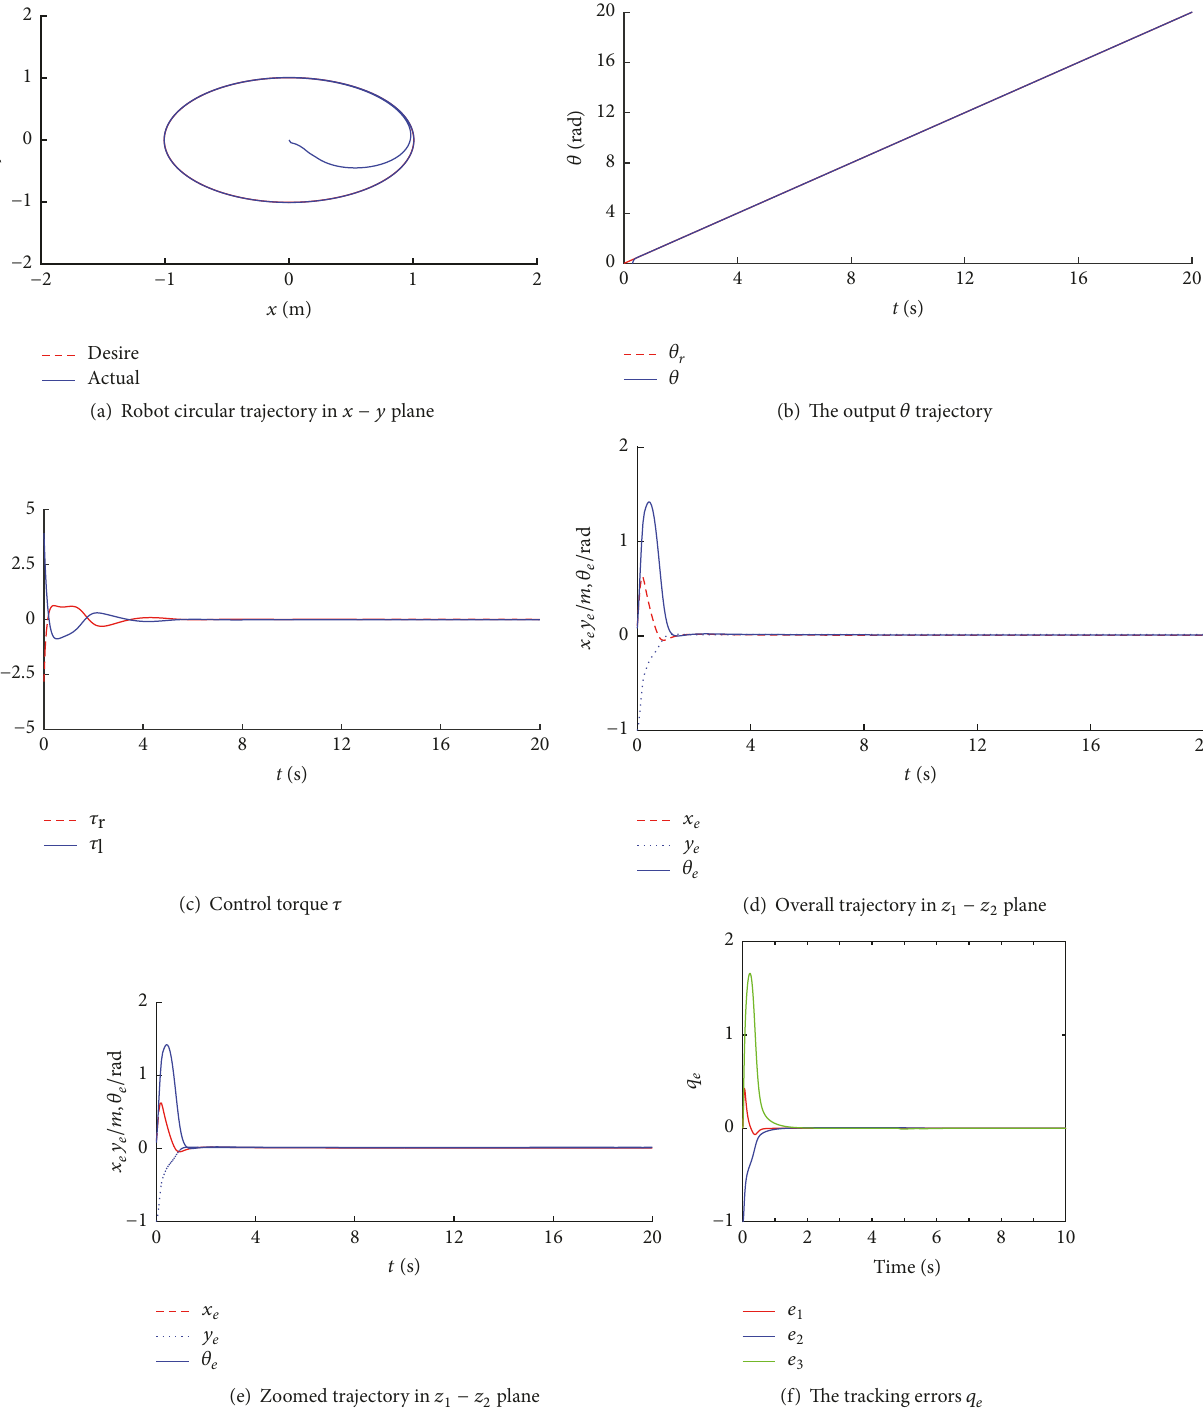
Figure 3: Simulation results of the mobile robot with the proposed